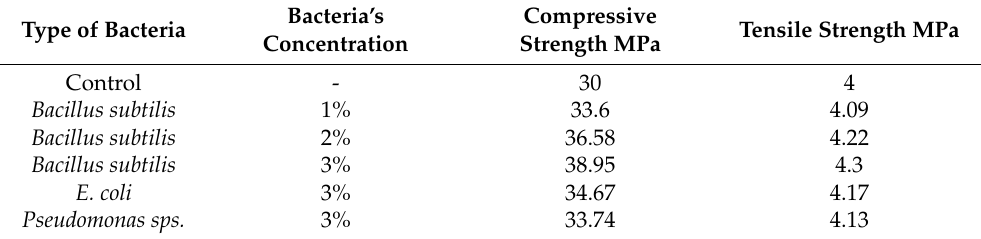
Table 3. Mechanical Properties of Bacterial Concrete with different percentages and